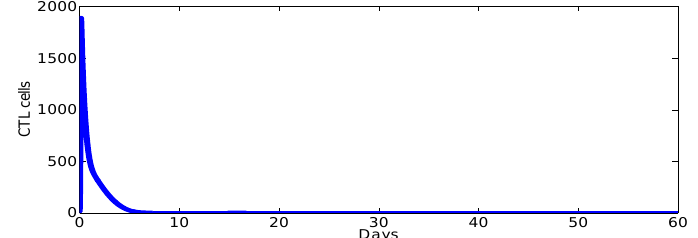
Figure 4. The behavior of the infection dynamics for λ = 1, d 1 = 0.0139, k 1 = 0.04, d 2 = 0.0495, k 2 = 1.1, d 3 = 0.5776, a = 100, d 4 = 0.6, p = 0.0024, c = 0.15, b = 0.5. For the parameters used in this figure, the basic reproduction number is 11.049 > 1. The immune response reproduction number R CTL = 3.596 × 10 − 1 < 1. In this case, all the solutions converge towards the endemic equilibrium E 1 = ( 19.96,5.98 × 10 − 1 ,1.14,199.78,0 ) .